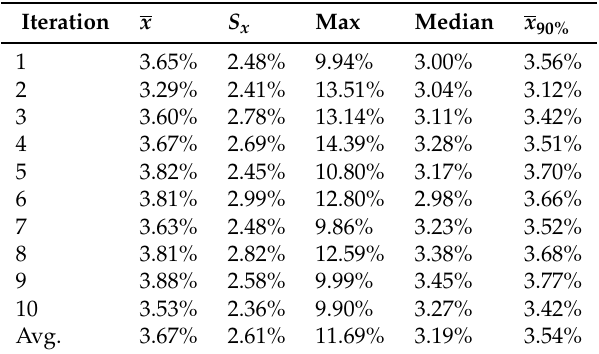
Table 1. Prediction deviation (as %) of the yield